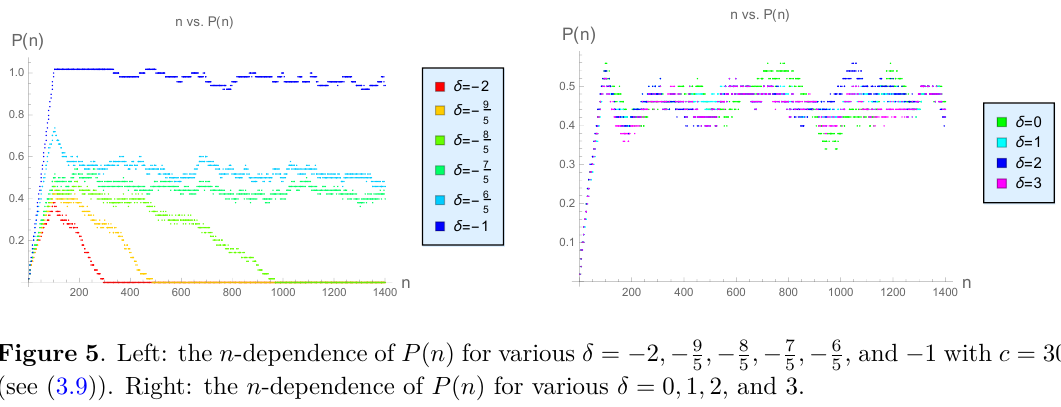
Figure 5 . Left: the n -dependence of P ( n ) for various δ = − 2 , − 9 (see (3.9)). Right: the n -dependence of P ( n ) for various δ = 0 , 1 , 2 , and 3